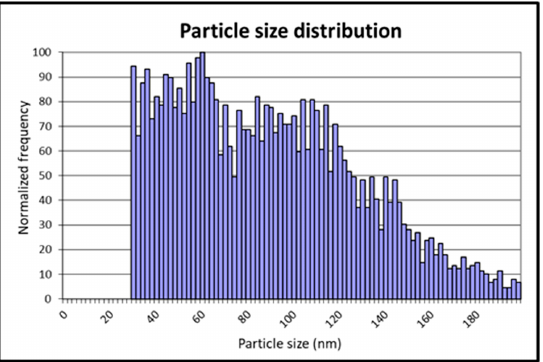
Figure 2. Size distribution of TiO 2 NPs pristine suspension obtained by sp-ICPMS.